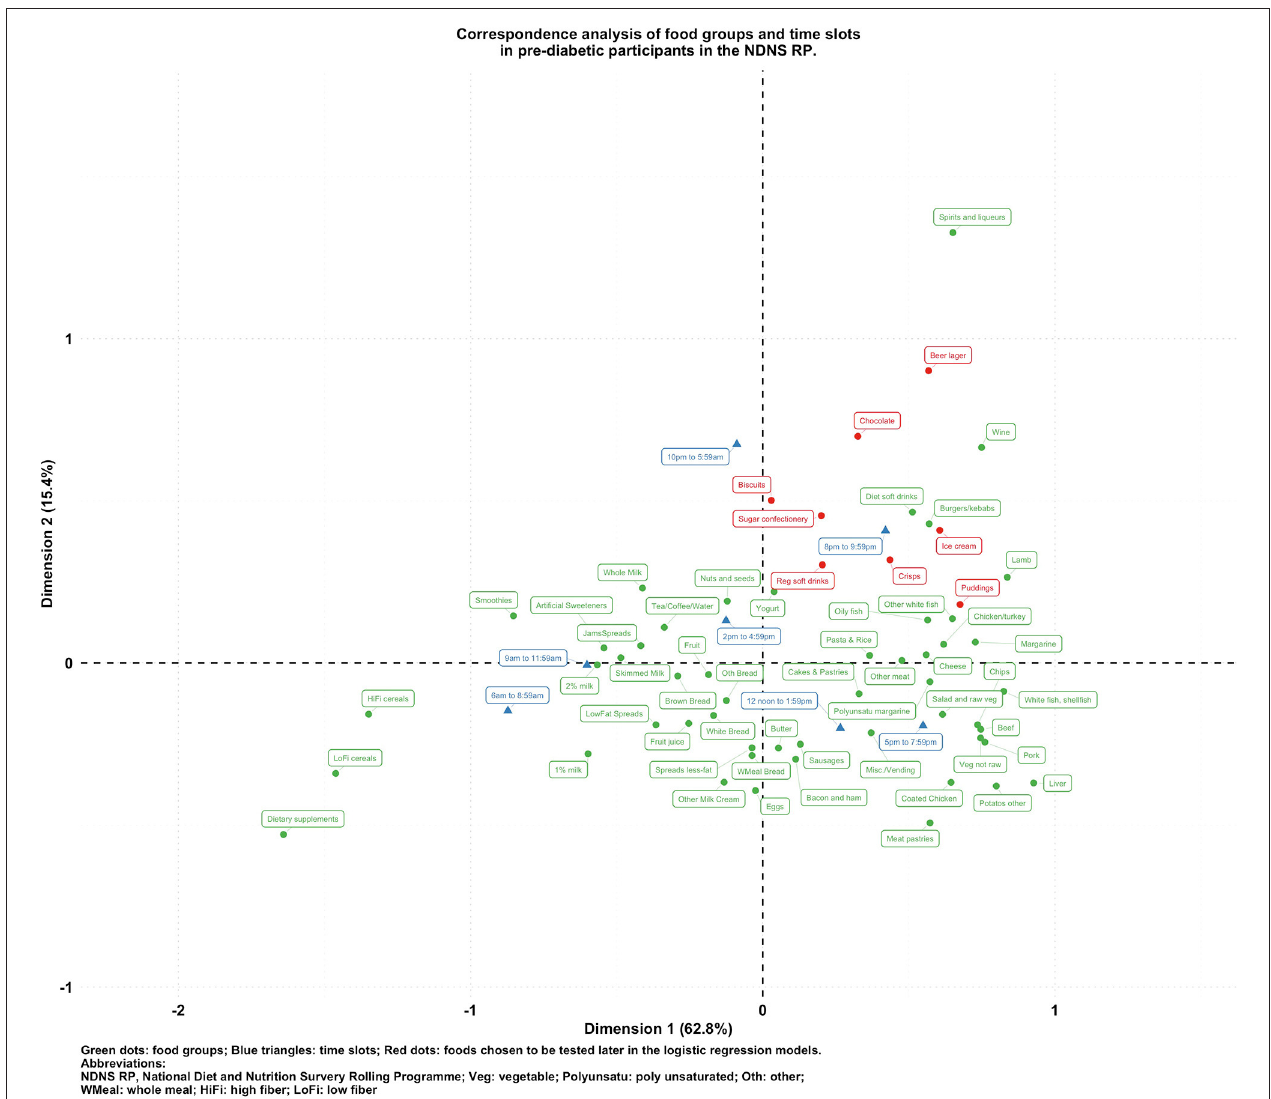
FIGURE 5 | Biplot of food groups and eating time slots in pre-diabetic participants in the NDNS